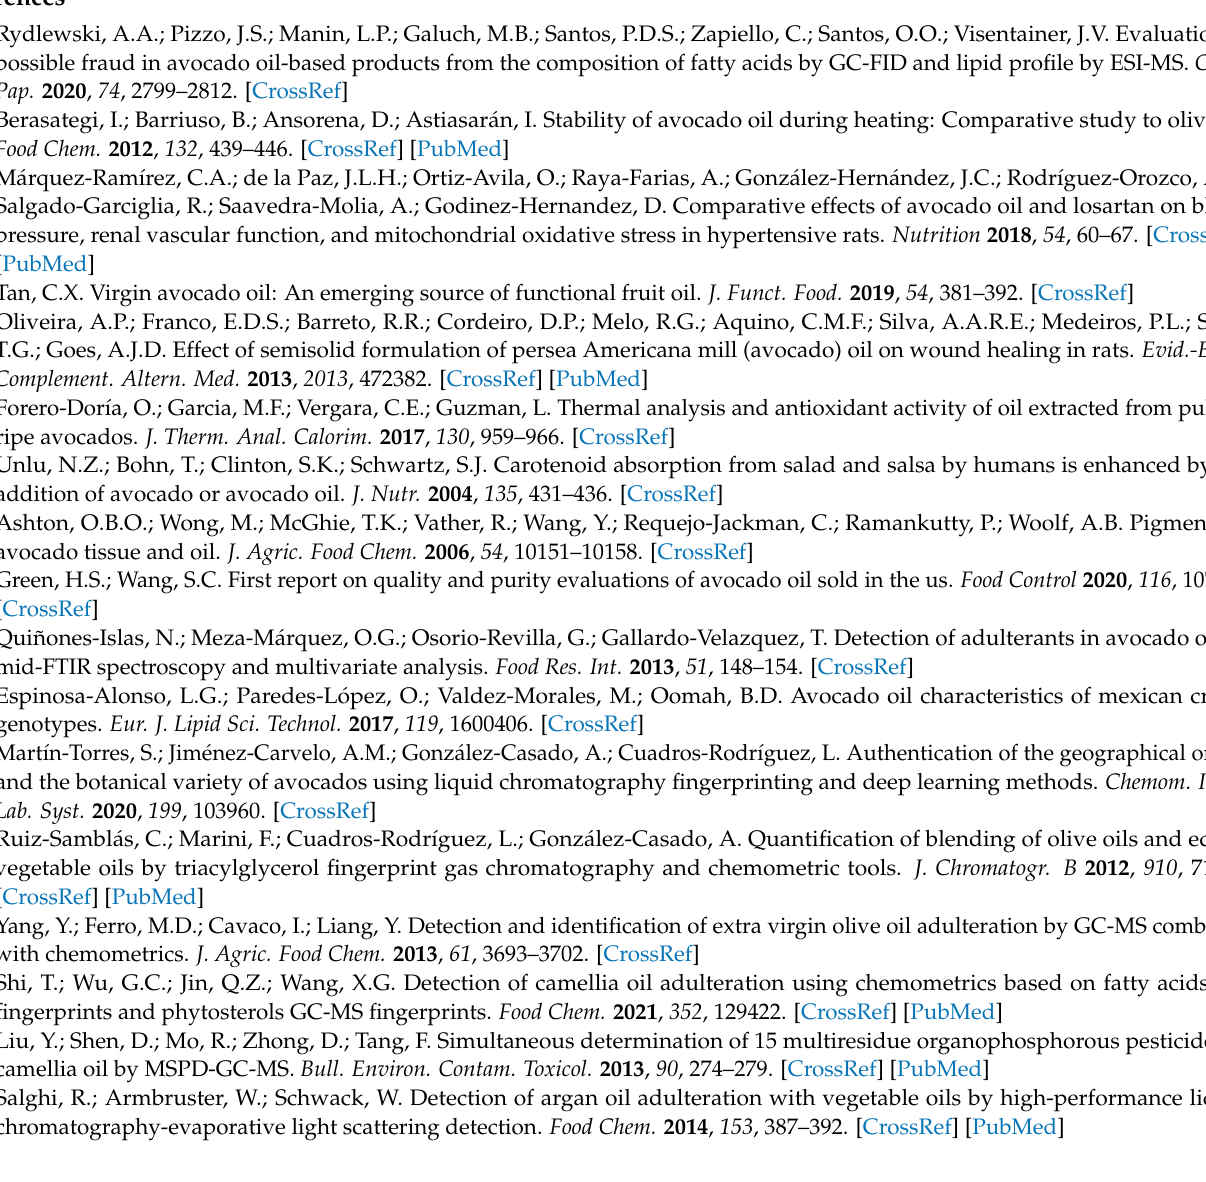
Table S5: Data used for the establish-ment of PLSR and SVR